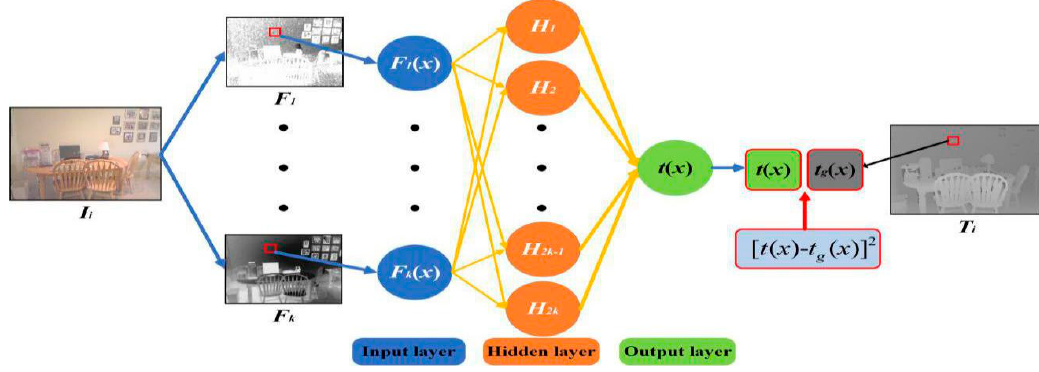
Figure 8. The generative network.